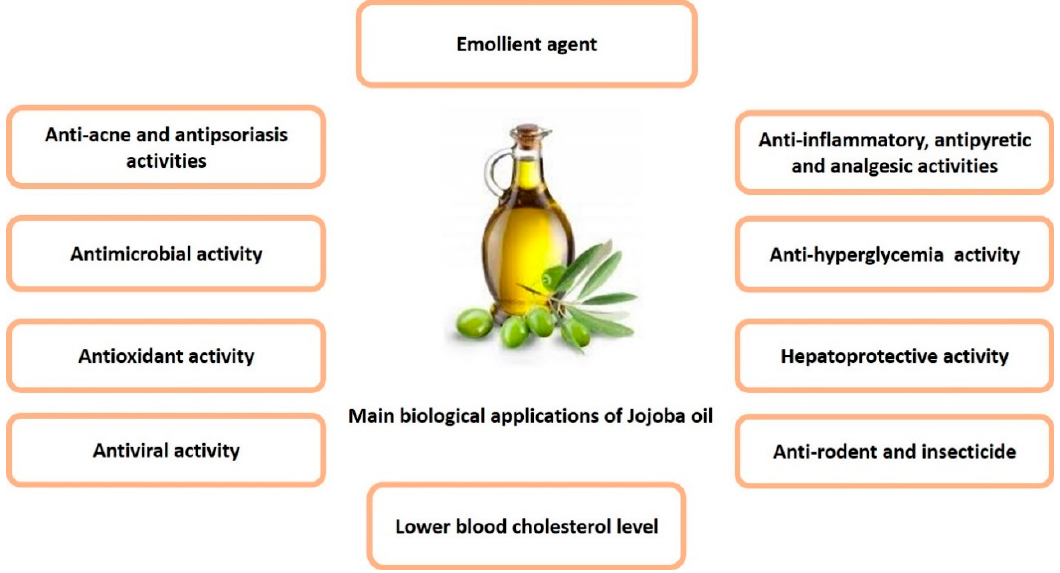
Figure 3. Summary of the main biological activities of jojoba